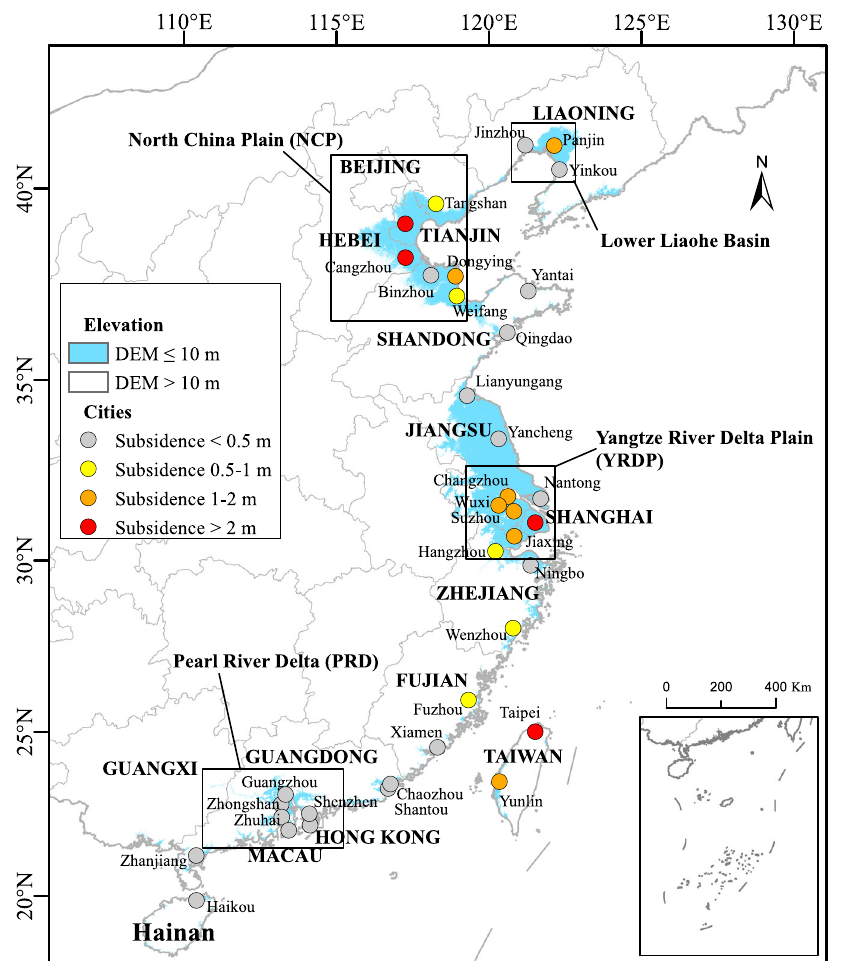
Fig. 1 | Observed anthropogenic subsidence of 36 coastal cities in China. The fi gure includes the low-elevation coastal zone (<10-m elevation), the major delta plains, and the observed maximum cumulative anthropogenic subsidence of 36